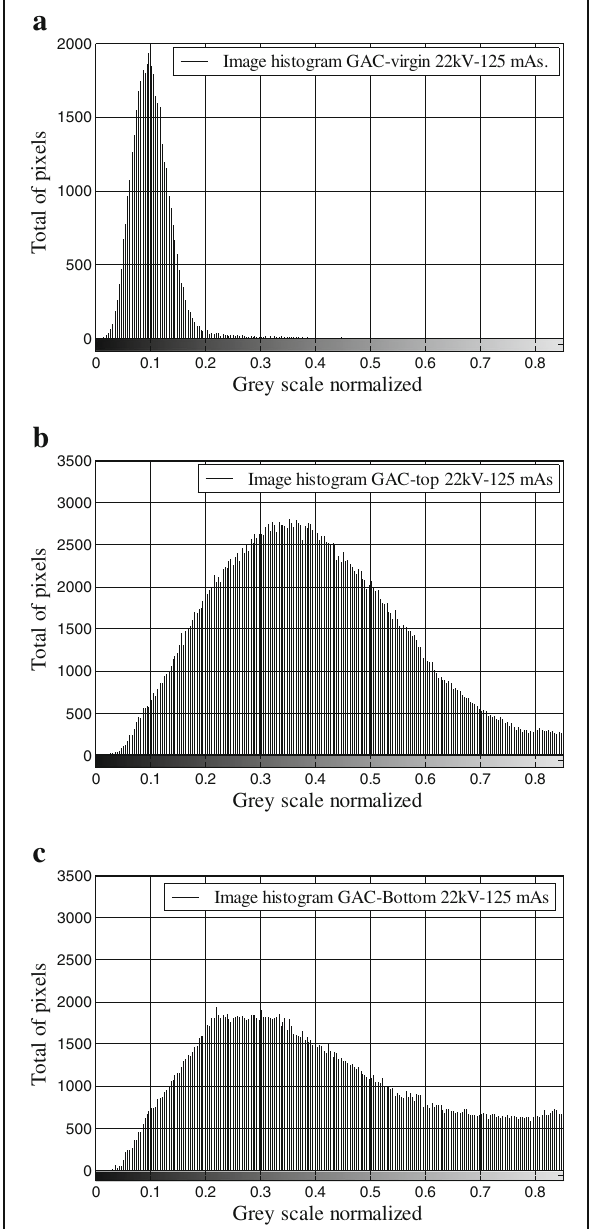
Fig. 10 Image histograms of the GAC-virgin ( a ), GAC-Top ( b ) and GAC-Bottom ( c )